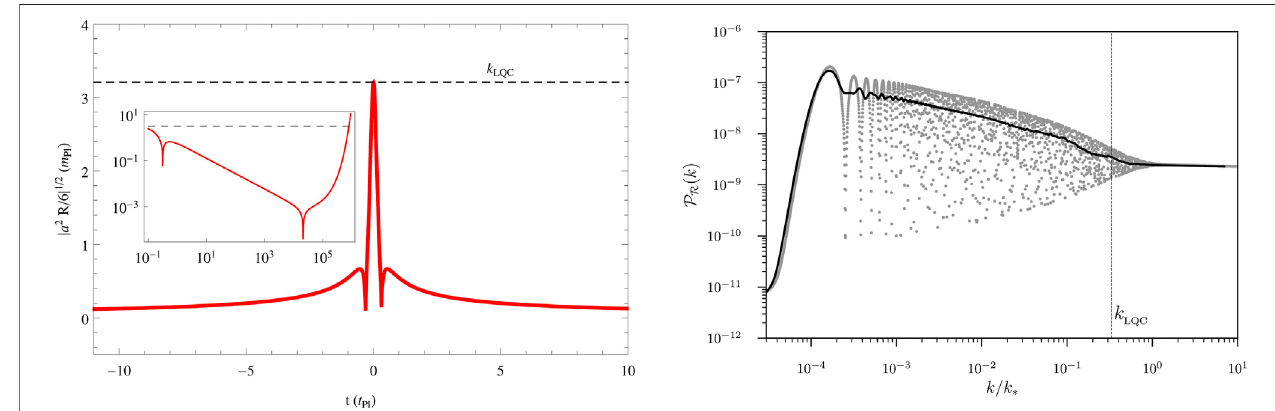
FIGURE4| Left:EvolutionoftheRicciscalarinLQC.Thisplotcorrespondstoasolutionoftheeffectiveequationswith71 e -foldsofexpansionbetweenthebounce and the end of in fl ation. Right: Primordial power spectrum of perturbations starting in an adiabatic initial state before the bounce in LQC. The gray dots correspond to numerically-obtained data for individual values of k , while the continuous black line is the average of the grey dots. This plot is obtained for the background geometry showed in the left panel.